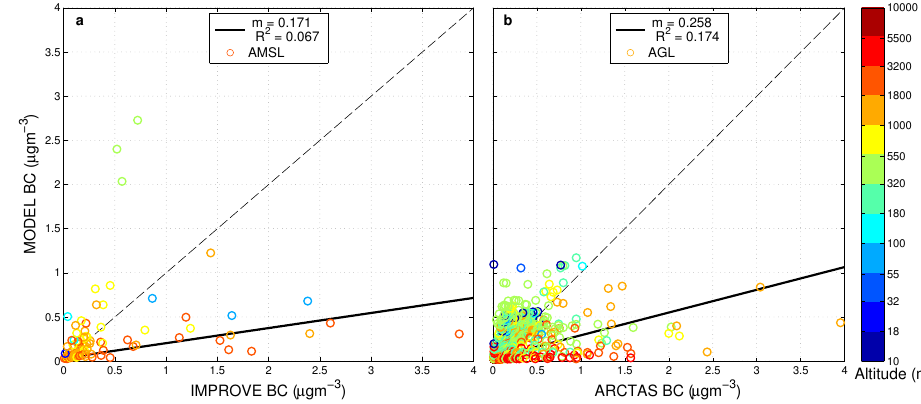
Figure 7. Linear fits between model BC concentrations with slope ( m ) and coefficient of determination R 2 for (a) IMPROVE surface and (b) ARCTAS-CARB aircraft observations colored by model height above mean sea level (a.m.s.l.) and above ground level